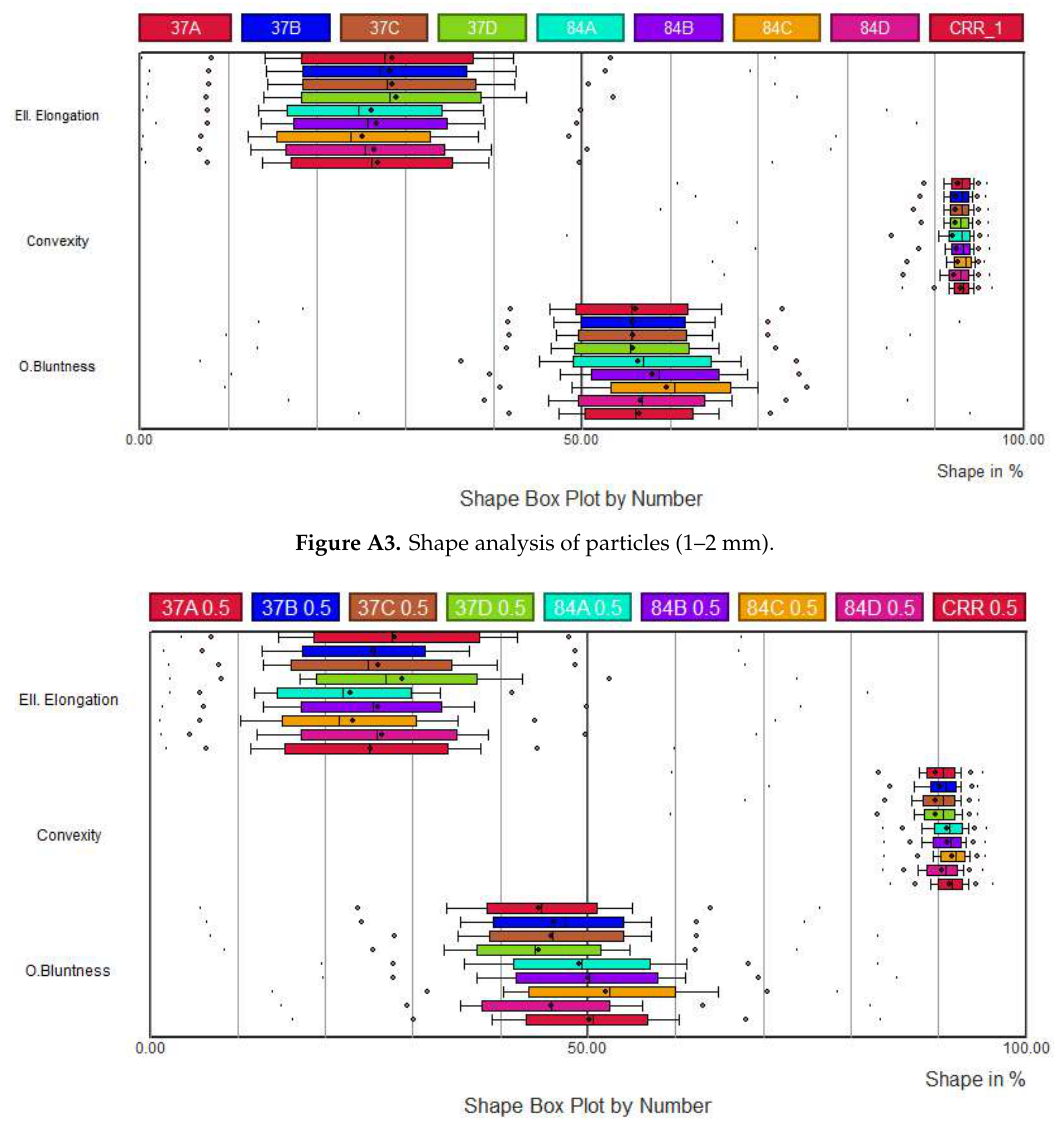
Figure A4. Shape analysis of particles (0.5–1 mm).